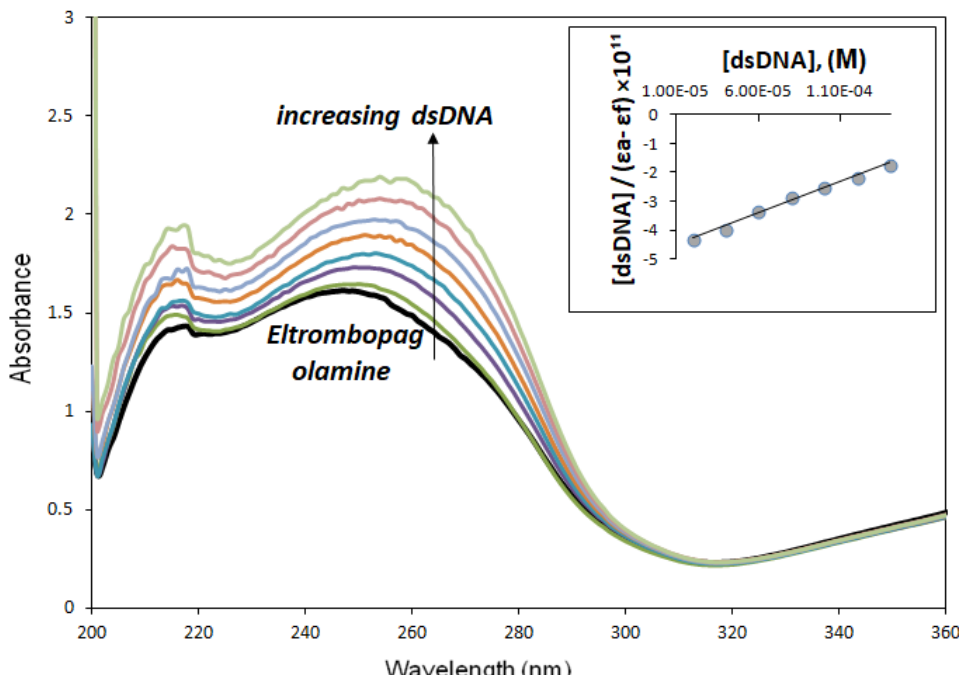
Figure 6. UV-Vis spectra of ELT (8 × 10 − 6 M) upon the titration of dsDNA (20–140 × 10 − 6 M) in buffer media. The increase in absorbance for an increase in dsDNA concentration is indicated by an “arrow”. The maximum wavelength of ELT ( λ max = 249 nm) shifted to 256 nm. K b was calculated from this linearity, showing the linear agreement between “[dsDNA]/( ε a − ε f )” and [dsDNA] in the Appendix ( R 2 = 0.9930).